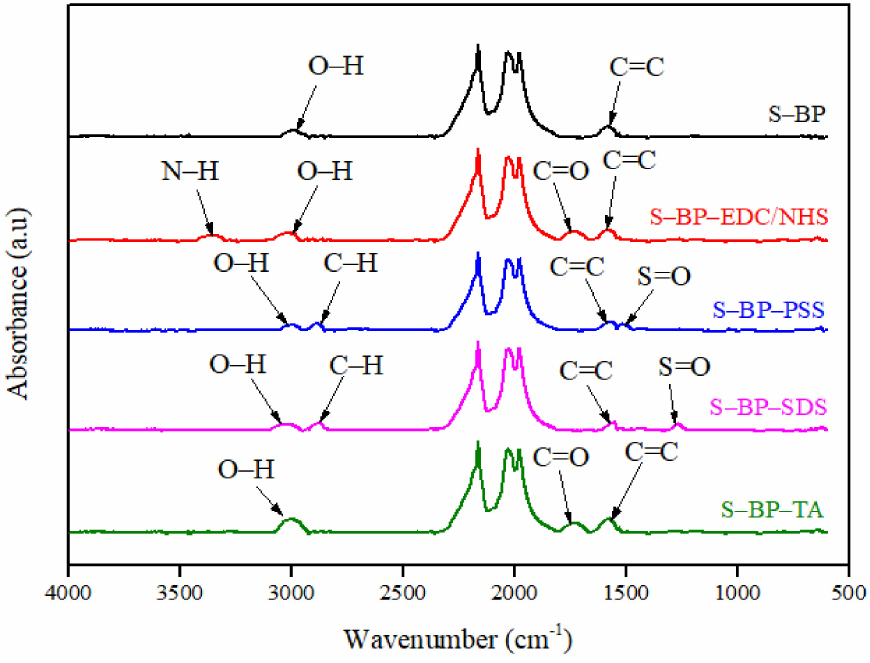
Figure 5. Fourier transform infrared spectroscopy (FTIR) analyses of various